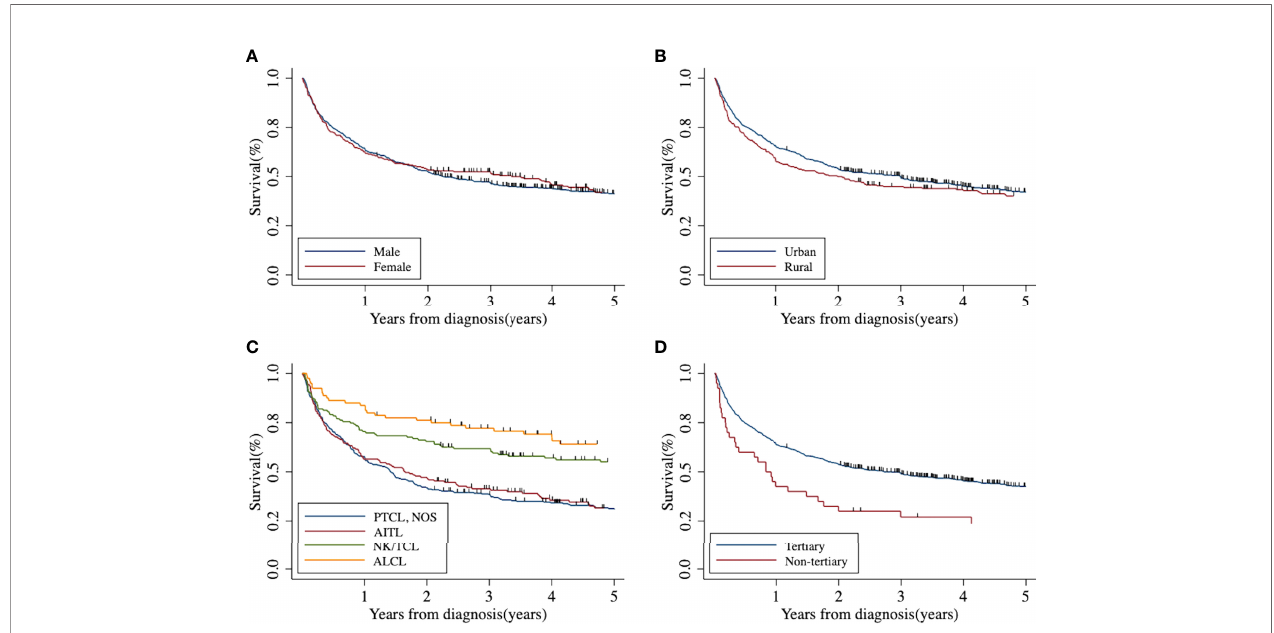
FIGURE 2 | Five-year Kaplan – Meier survival curve of peripheral T-cell lymphoma in Beijing from 2007 to 2018: (A) by sex; (B) by area; (C) by histological type; (D) by treatment hospital. AITL, angioimmunoblastic T-cell lymphoma; ALCL, anaplastic large cell lymphoma; NK/TCL, natural killer/T-cell lymphoma; PTCL- NOS, peripheral T-cell lymphoma not otherwise speci fi